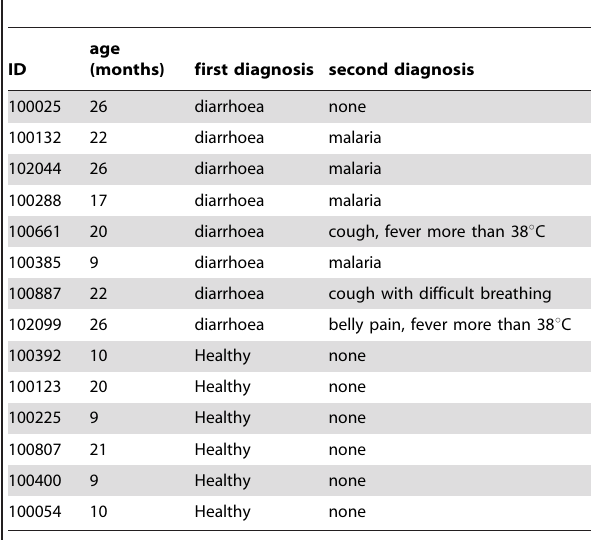
Table 2. Clinical symptoms present in 14 Gambian children with Non-Typhoidal Salmonella infections.